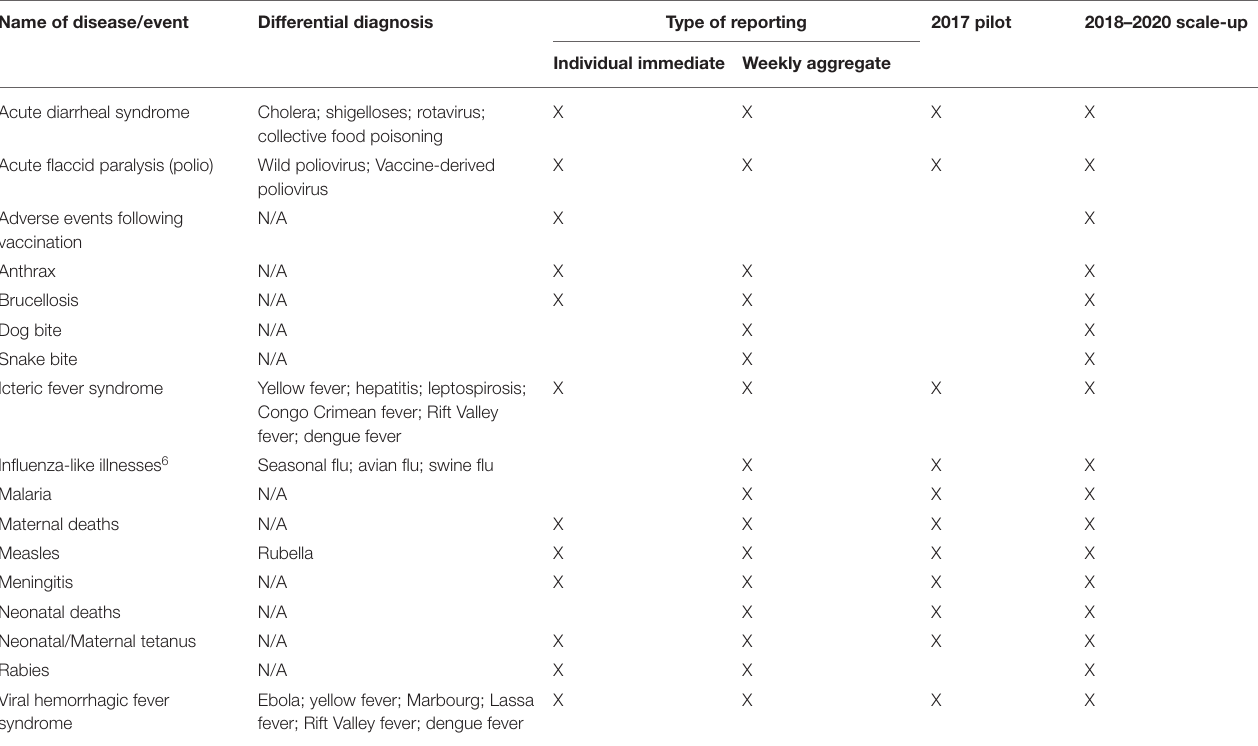
TABLE 1 | Epidemic-prone reportable diseases and events and type of reporting in Guinea,